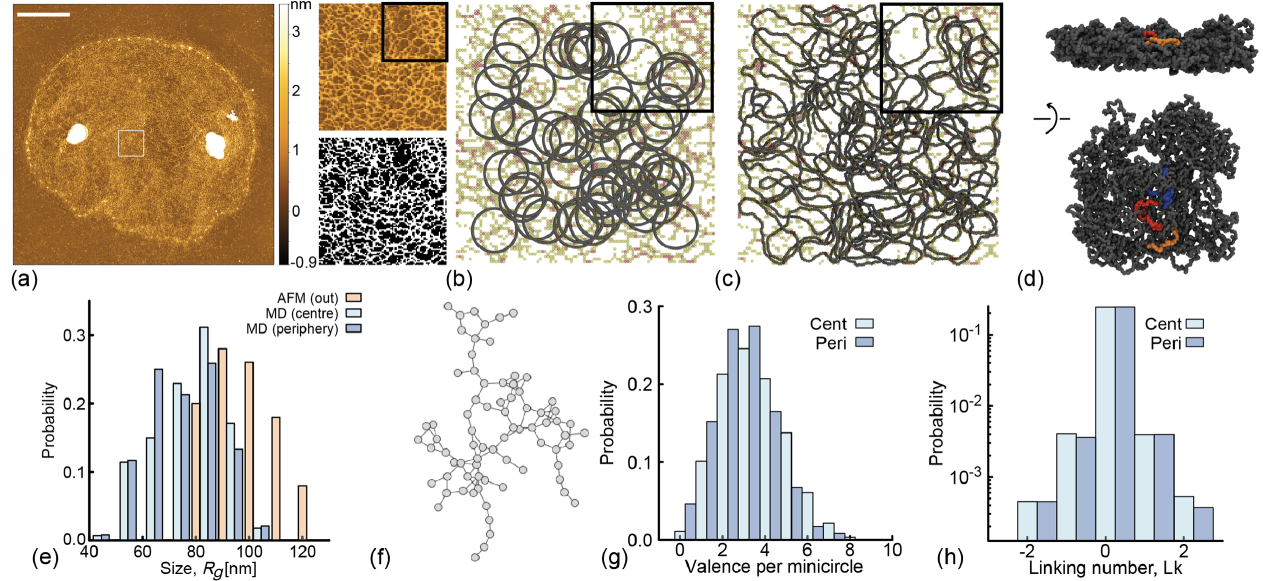
FIG. 6. (a) Figure showing a kDNA image (the scale bar is 2 μ m) and an enlarged 1 μ m 2 region with the corresponding thresholded image (black and white). (b) Starting configuration of the AFM steered MD: 90 rings are placed randomly in a quasi-two-dimensional simulation box. Phantom beads (yellow, orange, and red in the figure) are static and act as Gaussian attracting basins. (c) At the end of the MD simulation, we obtain ensembles of conformations that capture the correct length and size of minicircles, display no ambiguous crossings with other rings. and are compatible with the underlying AFM image. (d) Snapshot of the resulting network after having removed the slab confinement. (e) Distributions of R of the minicircles from AFM (picked from outside the kDNA) and of the g simulated ones (both from the center and periphery). (f) Network representation of (d), where each node is a minicircle and an edge between nodes represents that they are linked. Our simulated networks typically have all the nodes in one large connected component. (g) Distribution of valence, showing that the central minicircles are on average more connected than the peripheral ones. (h) Distribution of linking number, showing that the most linked pairs are singly linked, and about 10% of them are doubly